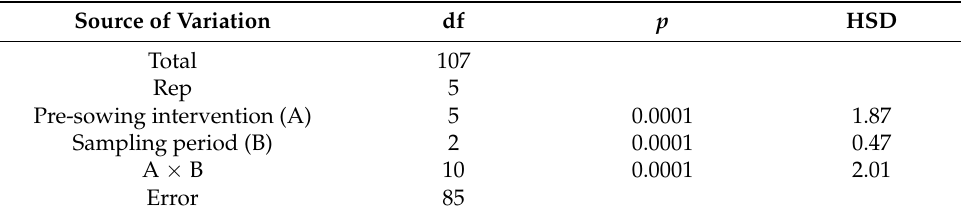
Table 10. Factorial analysis of the total capture of members of the family Carabidae. Source of Variation df p HSD Total 107 Rep 5 Pre-sowing intervention (A) 5 Sampling period